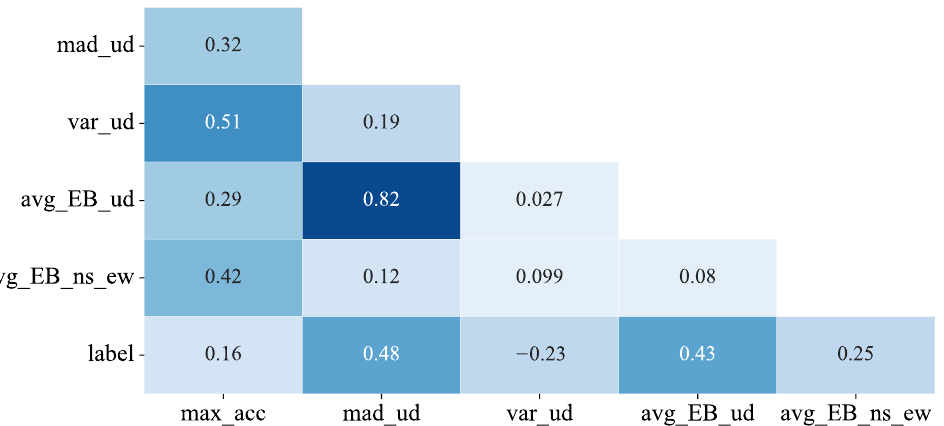
Table 3. Performances of Fully Connected Neural Networks (FCNNs) with different feature dimen- sions of